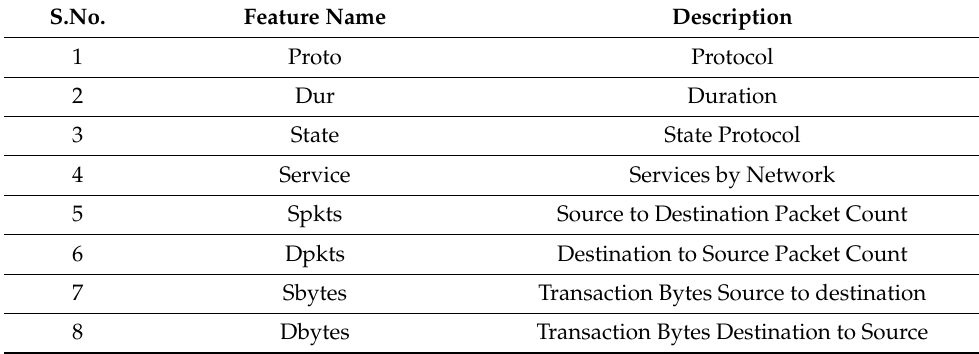
Table 1. Selected